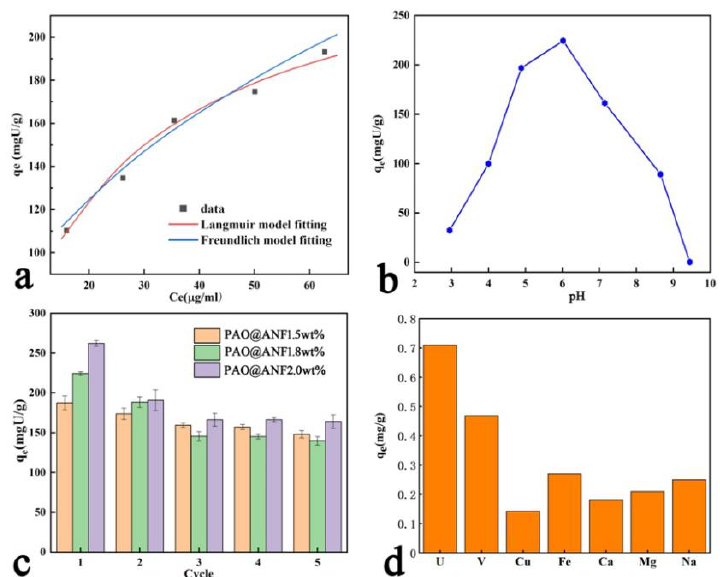
Figure 5. ( a ) Equilibrium adsorption isotherms fitted with Langmuir model and Freundlich model;